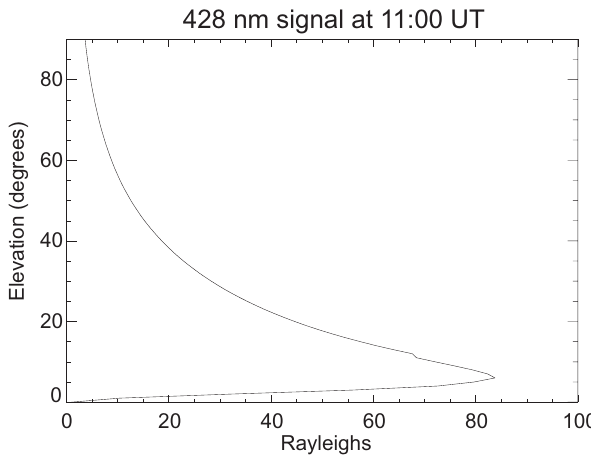
Fig. 13. Variation of the modelled MSP signal at 428nm with ele- vation at 11:00 UT. The peak at lower elevations occurs because the corresponding rays have longer paths in the troposphere and suffer greater